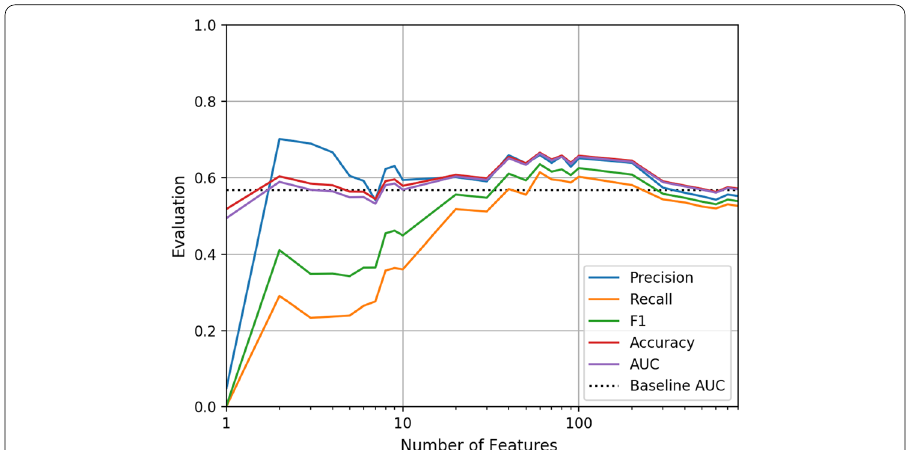
Fig. 8 A comparison of the performance prediction of the baseline model vs feature optimized